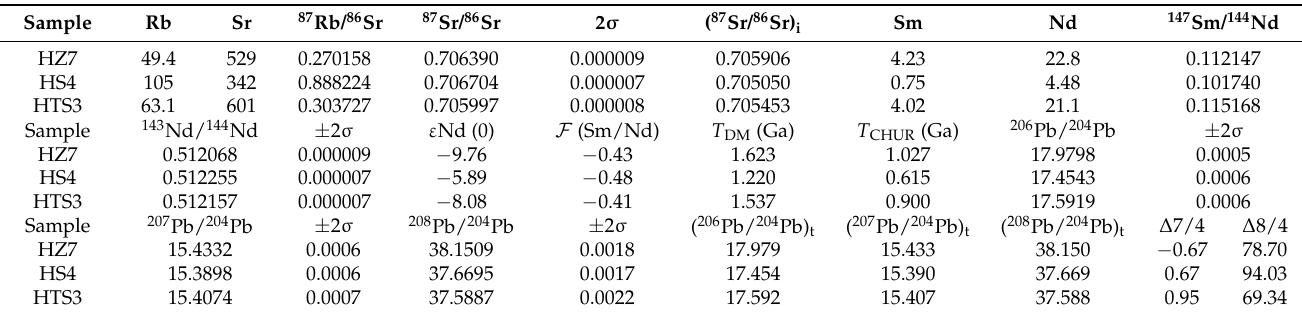
Table 4. Sr-Nd-Pb isotopic compositions of the quartz monzonites in the Jinling area, western Shandong